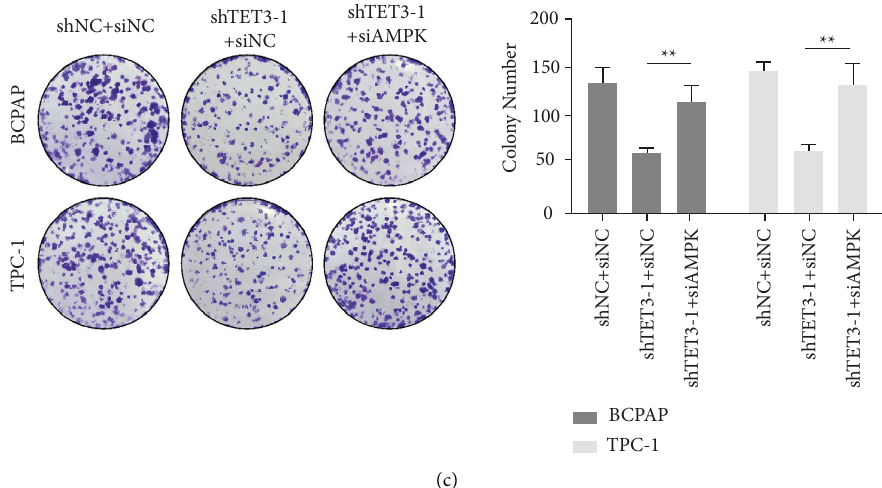
Figure 5: (a) Western blotting was used to detect phosphorylated AMPK, phosphorylated mTOR, phosphorylated ULK1, ATG5, and LC3BII/I in BCPAP and TPC-1 cells treated with TET3 knockdown or AMPK knockdown. CCK-8 assay (b) and colony formation assay (c) showed that AMPK knockdown partially attenuated the inhibited proliferation induced by TET3 knockdown in BCPAP and TPC-1 cells.